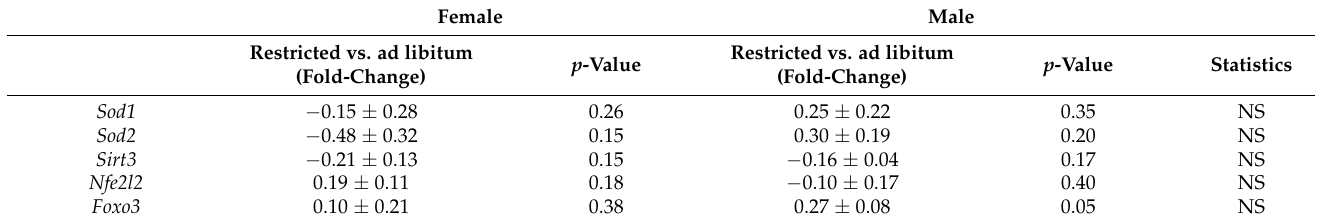
Table 3. mRNA expression levels of antioxidant genes. Two-way ANOVA was performed to assess for significance. NS: non-significant. Sod1 : superoxide dismutase 1; Sod2 : superoxide dismutase 2;